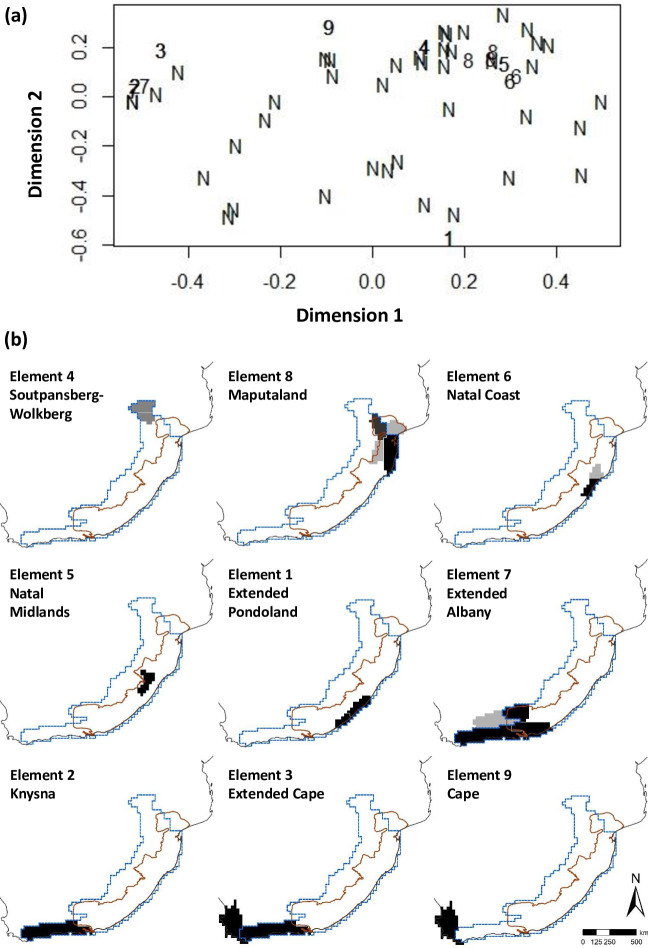
Biotic elements of land snails in south-eastern Africa.(a) First two dimensions of the nonmetric multidimensional scaling of the distribution ranges of land snails of south-eastern Africa based on their incidence in pre-defined operational geographic units (Fig 1). Biotic elements found by PRABCLUS are denoted by 1‒9; N = noise component. (b) Distribution maps of the nine biotic elements of the land snail fauna of south-eastern Africa. Four different shadings from light to dark indicate the areas where >30%, >45%, >60% and >100% of the species of each element are present. The MPA hotspot boundary is reprinted from Hoffman et al. [26] (public domain).